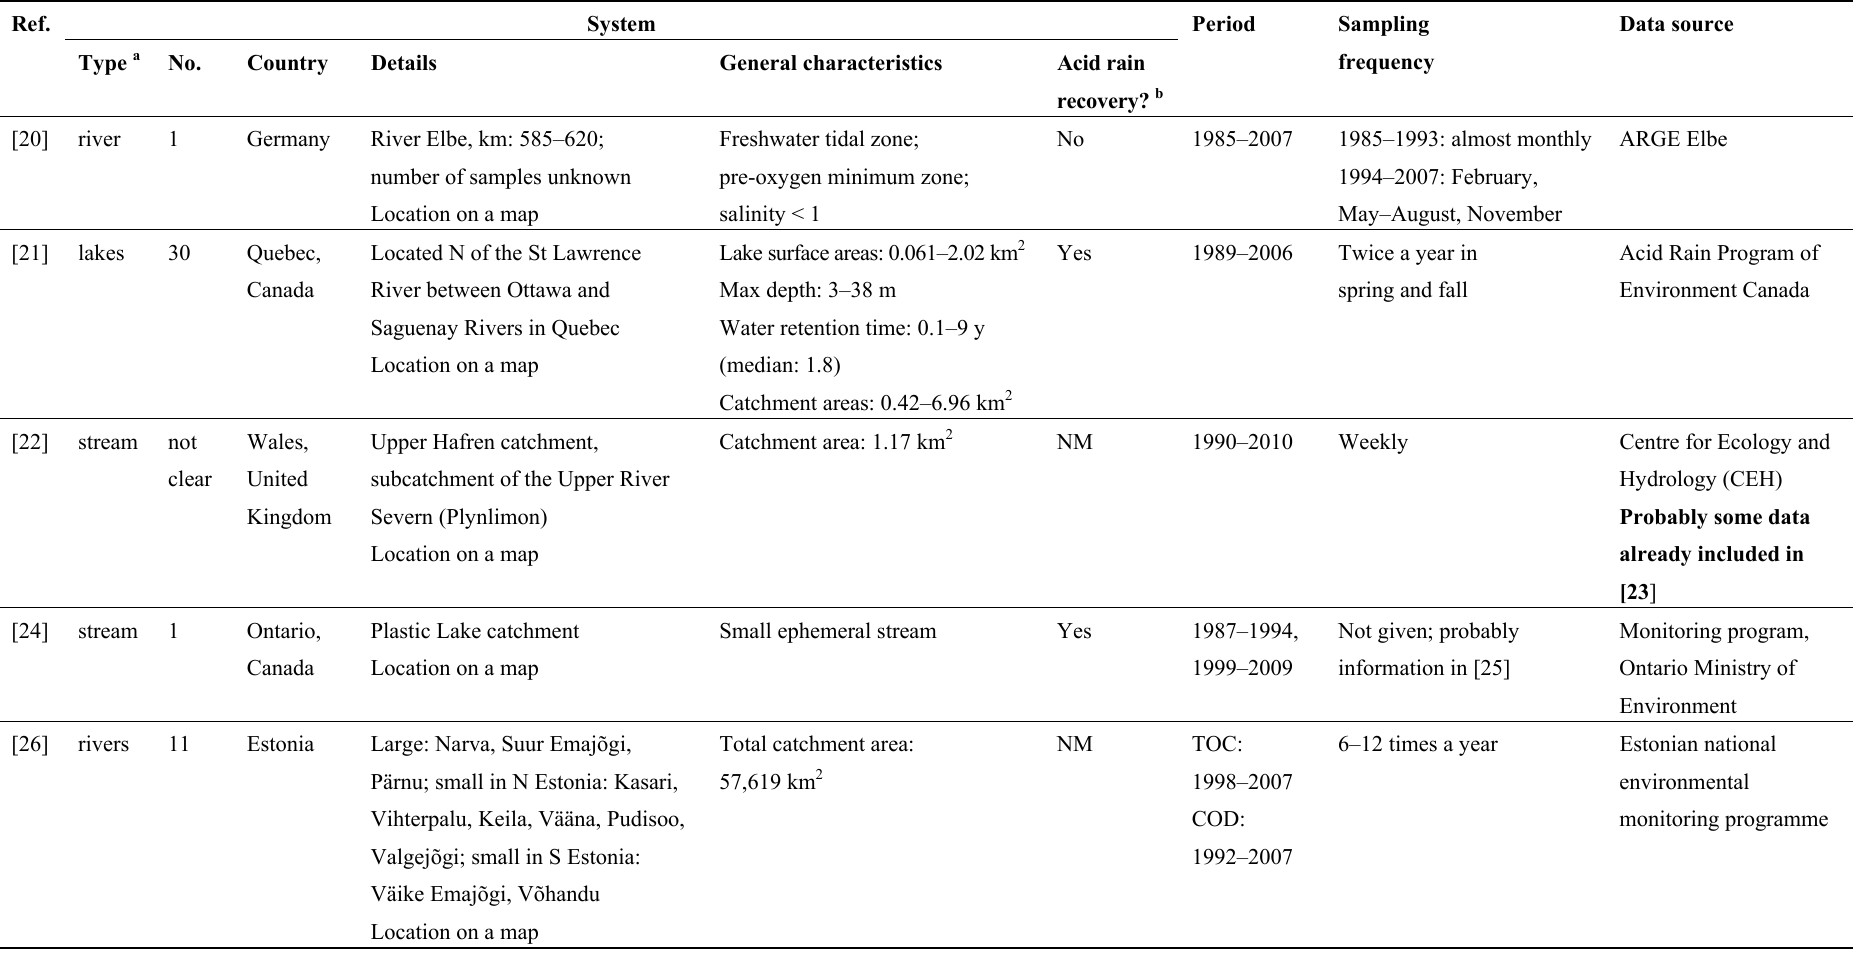
Table 1. Published studies containing long-term organic carbon concentration temporal trends in freshwaters. System characteristics, sampling details and data